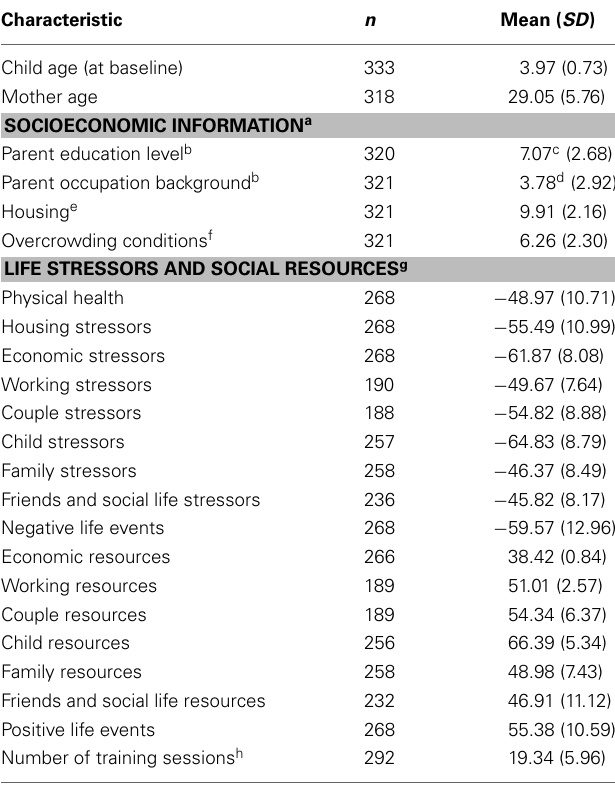
Table 9 | Socio-demographic information of the CTP sample (continuous variables).